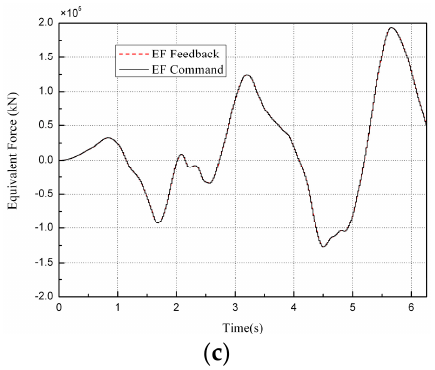
Figure 19. Comparison of the EF feedback and EF command for ( a ) the first floor; ( b ) the second floor; ( c ) the third floor.